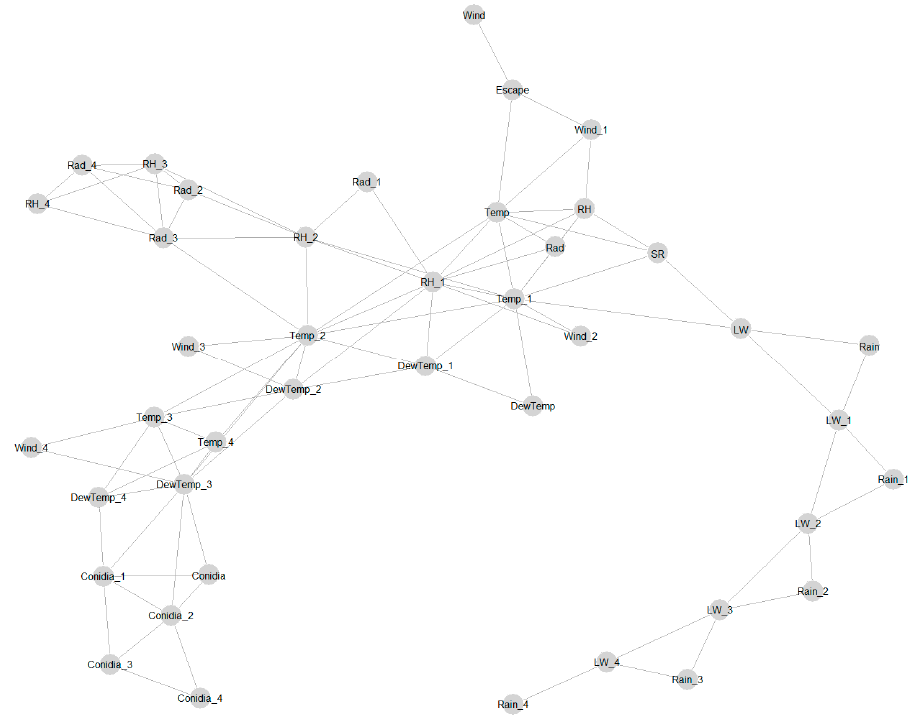
Figure 8. Graphical model showing conditional dependence/relationships between different daily weather variables and conidia on different days. The weather variables were temperature (Temp), dew temperature (DewTemp), relative humidity (RH), wind speed (Wind), spore escape (Escape), spore release (SR), leaf wetness (LW), solar radiation (SR), and rainfall (Rain). The variable (weather and conidia) numbers 1, 2, 3, and 4 indicate measurements taken 1, 2, 3, and 4 days ago, whereas those without numbers were measured or recorded on the current day.